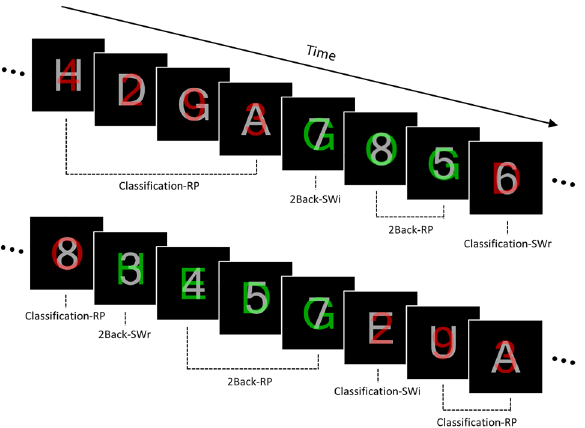
Figure 1. Task stimuli and conditions used in the experiment. For red stimuli, the task required participants to classify the stimuli as odd/even or vowel/consonant according to whether the current red target was a number or letter, respectively (i.e., the classification task). When the stimulus color was changed to green, participants were required to determine whether the current target in green was identical to the stimulus that was presented in red or in gray two trials before. RP repeat, SWr switch-relevant, SWi